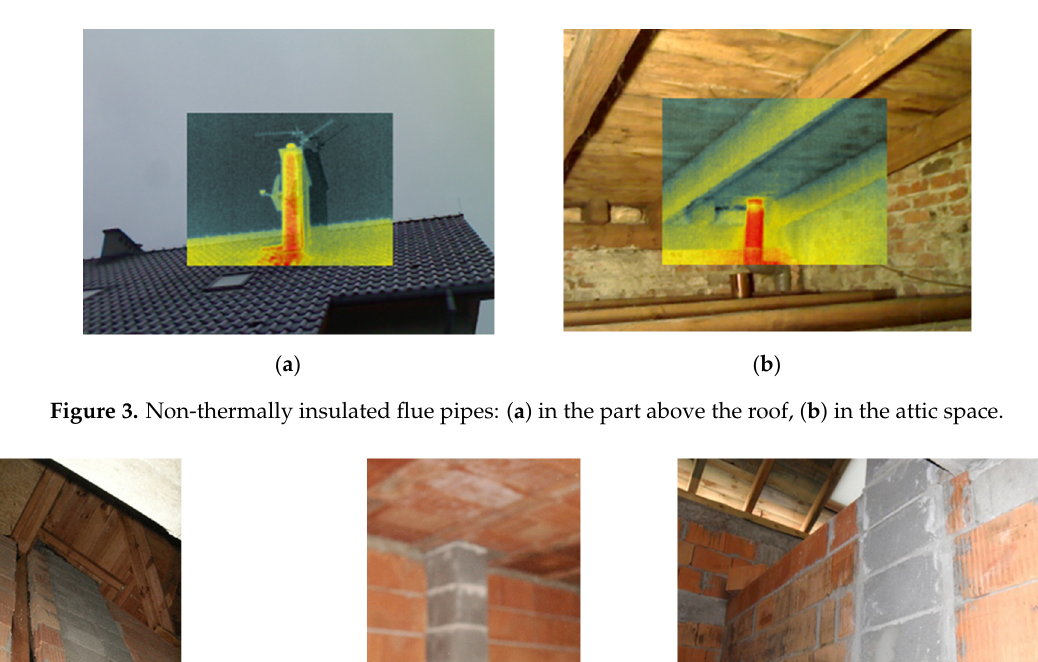
8 of 33 (linear and surface ones) often occur in places where chimneys are led above roofs, above heated floors. This phenomenon cannot be fully eliminated by applying common solu- tions, but its effects may be considerably limited. Intentional or unintentional, periodical switching off of parts of the storey, premises or only single rooms or inefficient or even inefficient ventilation may also turn out to be an important element in generating heat losses. The authors tried to present such cases on the basis of observations and own re- search verified by simulation models. The cases shown in Figure 3 are quite common in construction practice, which may indicate a disregard for this problem, poor knowledge of designers, and lack of awareness of building owners and managers. Such situations not only generate higher operating costs of buildings but, above all, are the cause of significant emissions into the atmosphere due to incomplete combustion of fossil fuels. In addition, the cooling of chimney walls and adjoining walls occurs, which contributes to their slow but progressive chemical and biological degradation due to the deposition of aggressive substances on them. Such situ- ations are also a direct source of microbiological risk for the inhabitants of the top floors of buildings.